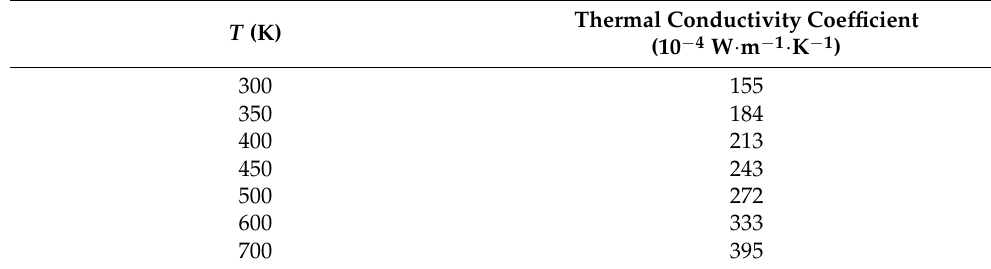
Table 2. The thermal conductivity coefficient variation of SF 6 with respect to the temperature.